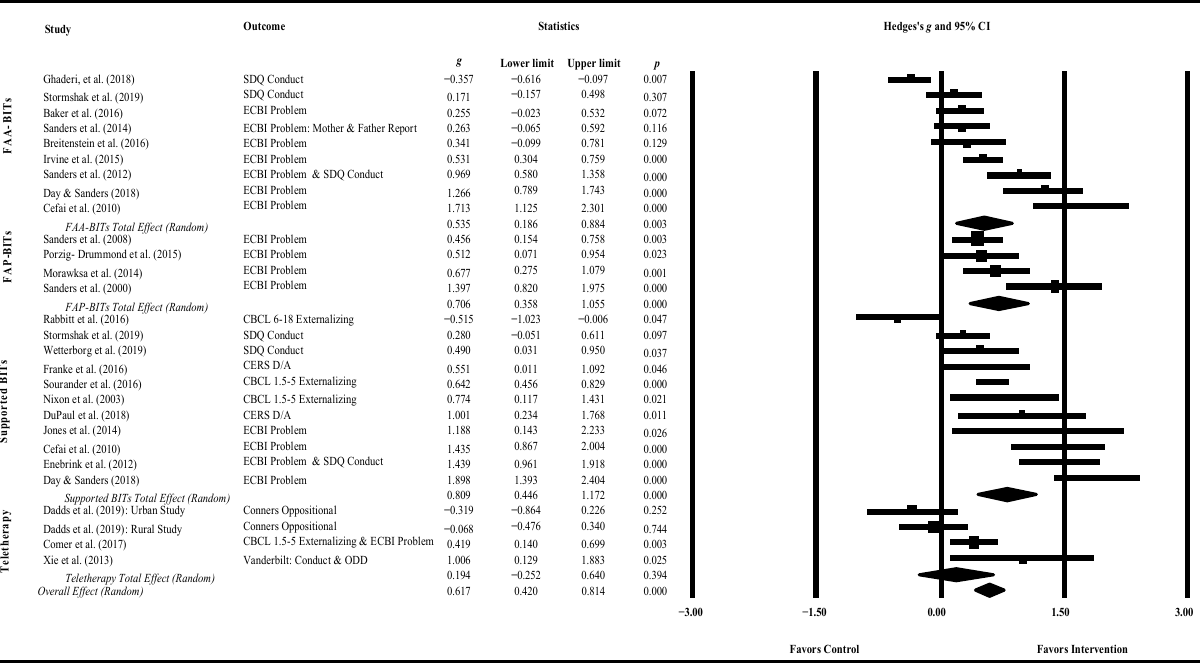
Figure 2. Forest plot: All studies (active and waitlist control). Risk of bias was analyzed by evaluating funnel plot symmetry and calculating Rosen- thal’s Fail-Safe N (Rosenthal 1979). The funnel plot in Figure 3 displays the studies’ effect estimates (Hedges’s g; x -axis) against their precision, as measured by their standard errors ( y -axis). Studies that are more precise with smaller standard errors cluster around the central line, which represents the overall effect size of the studies (Hedges’s g; vertical line). Studies without bias and between study heterogeneity form a symmetrical funnel with studies clustered around the center line. After a collaborative review, the funnel symmetry was determined to be asymmetric (Borenstein 2005; Sterne et al. 2011). For all studies (i.e., BIT compared to active and waitlist controls), 14 of the studies fell within the funnel plot and, thus, clustered around the overall effect size, but 14 studies pulled